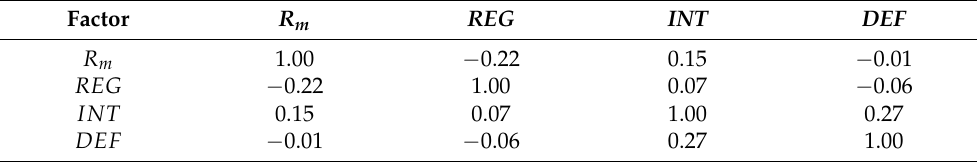
Table 4. Risk factor correlation matrix.